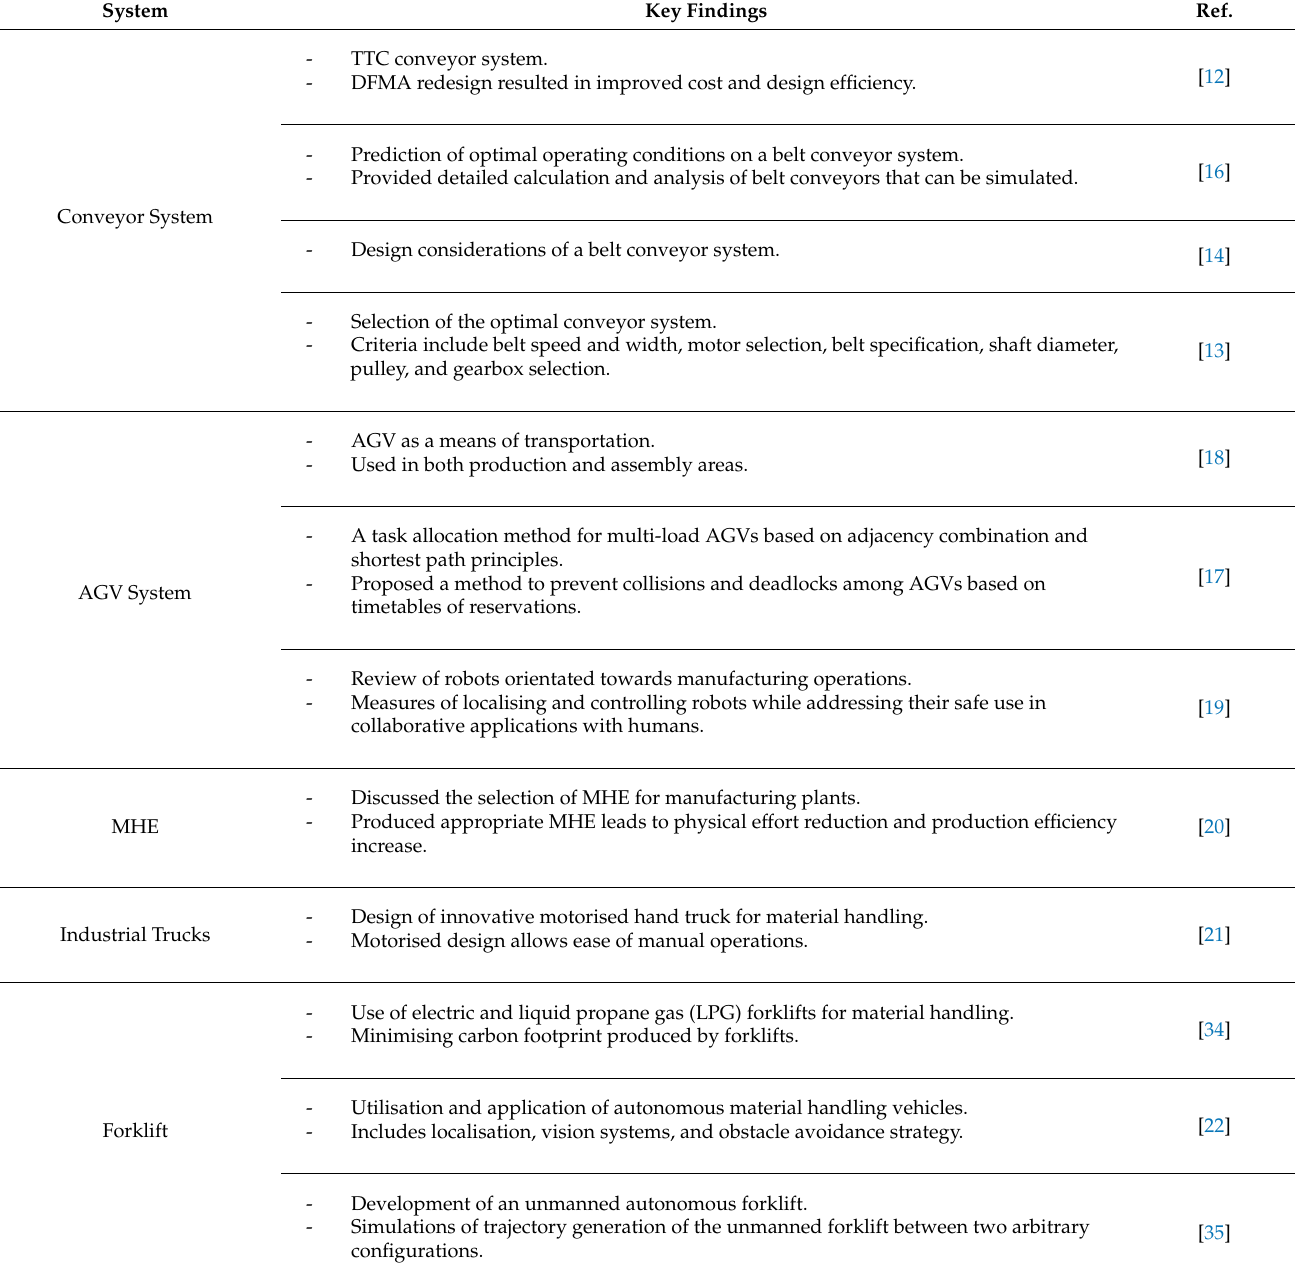
Table 2. Summary of key findings of past studies on transportation systems. Key Findings